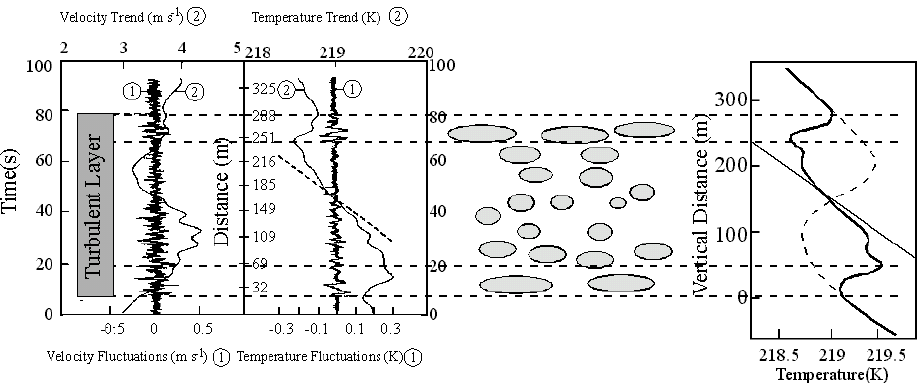
Fig. 10. Expected behaviour of velocity, temperature, and refractive index inhomogeneities within a turbulent layer. In the left-hand two graphs, the smoother lines represent the mean wind and temperature profiles (labelled (2)), while the more rapidly varying lines passing up through the centre (labelled (1)) represent fluctuations of the appropriate parameter about the mean. In the right-hand graph, the broken line represents an intitial temperature profile and the solid one represents the profile after the turbulence is established (from modeling studies). Note that the vertical scalings are slightly different in the left- and right-hand profiles, since each comes from a different source. We have adjusted the scalings so that the temperature profiles look similar. In between these graphs we show the shapes of “average” eddies as a function of position within the layer, demonstrating greater anisotropy at the top and bottom of the layer. See text for other details.